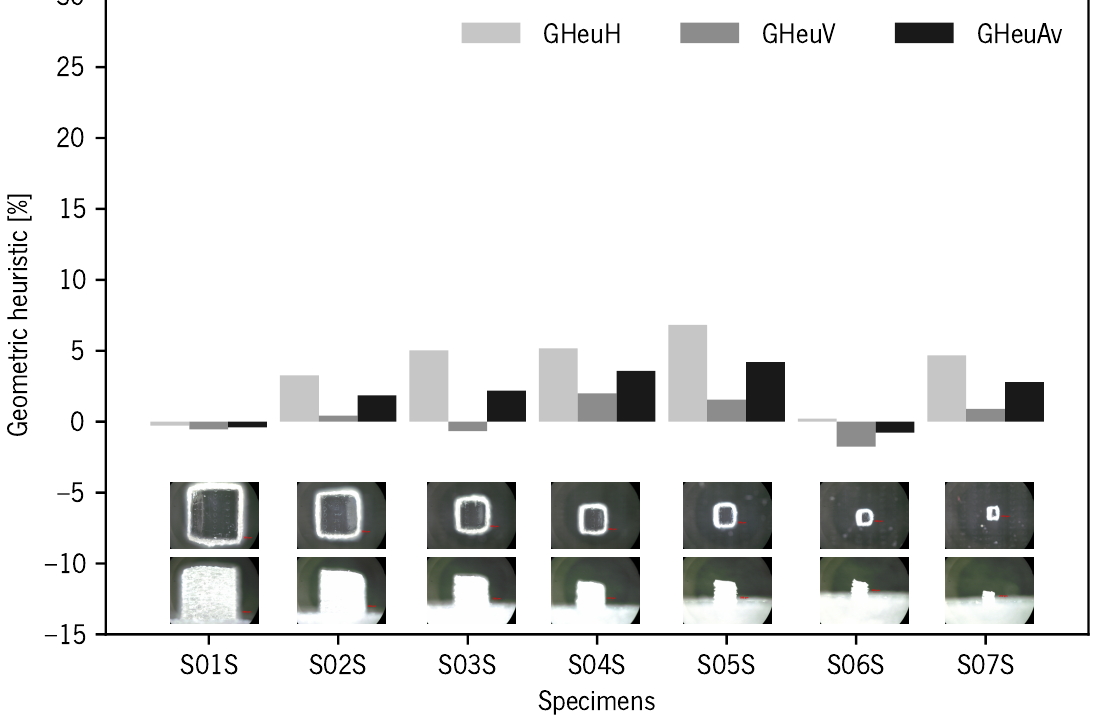
Figure 11. Geometric heuristic diagram for specimens produced with support material. Below the diagram, the representa- tive images corresponding to each